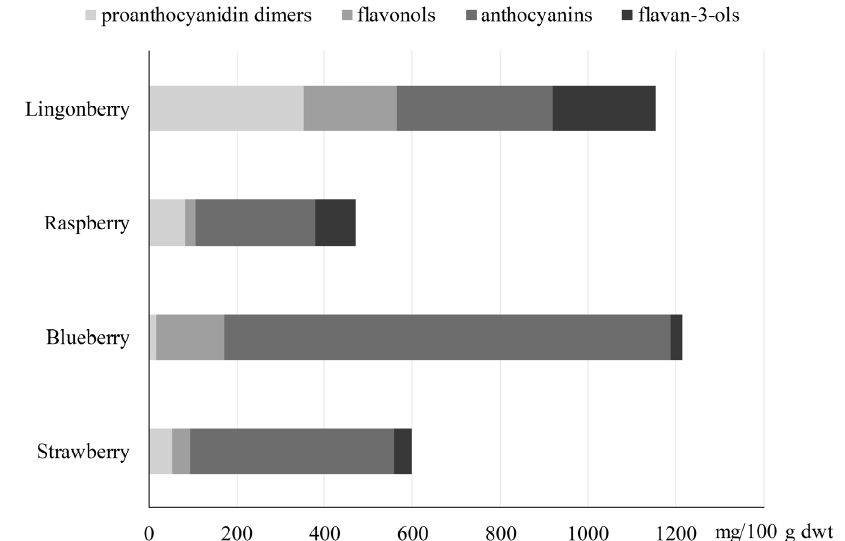
Figure 3. Mean content (mg / 100 g dwt) of four subgroups (proanthocyanidins, flavonols, anthocyanins, and flavan-3-ols) of flavonoids in di ff erent varieties of lingonberry ( n = 2), raspberry ( n = 3), blueberry ( n = 4), and strawberry ( n = 7). Analyses were carried out in triplicate. In lingonberries, a total of three anthocyanins, seven flavonols, two flavan-3-ols, and four proanthocyanidins were quantified (Tables 2 and